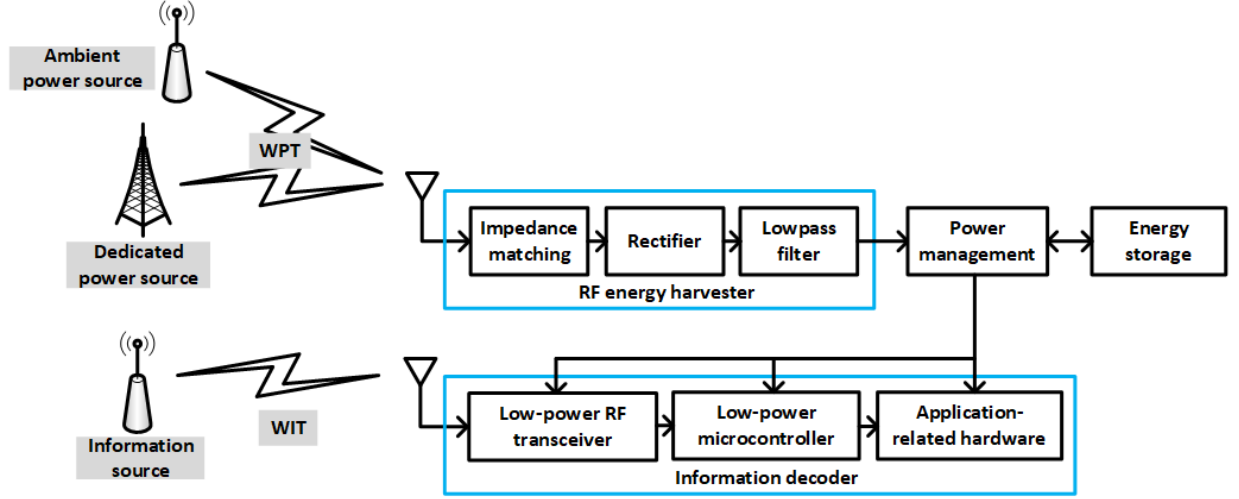
Figure 1. WIPT scenario, with separated WIT and WPT segments. The WIT segment contains conventional hardware to receive information, whereas the WPT segment is essentially a voltage rectifier followed by a low-pass filter devoted to extracting the DC component of the received signal.